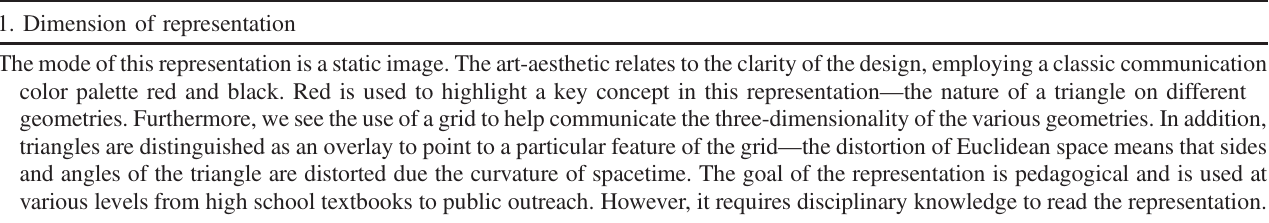
TABLE II. Unpacking the representation of the geometry of the Universe (Fig.